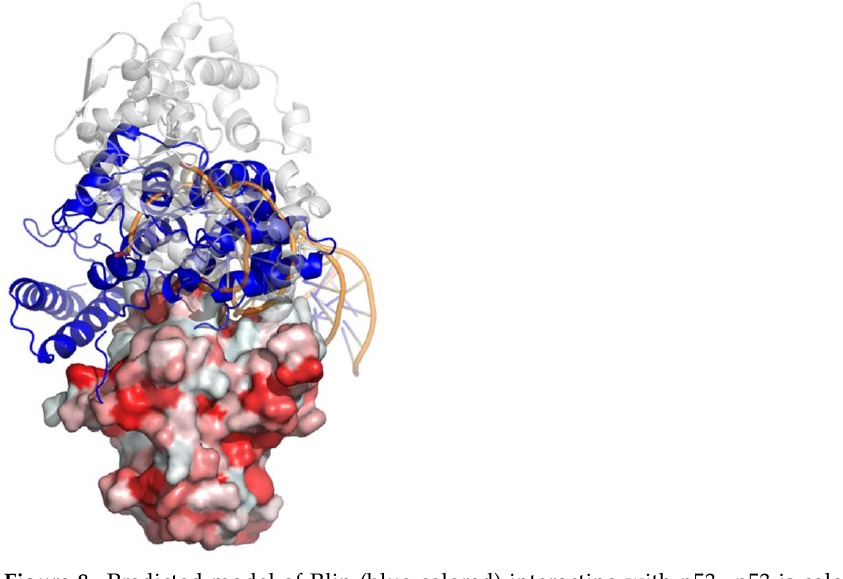
Figure 8. Predicted model of Rlip (blue-colored) interacting with p53. p53 is colored as red hydro- phobic surface. The LT_SV40 (grey-colored) and DNA (orange-colored) that bind to p53 are also superimposed.